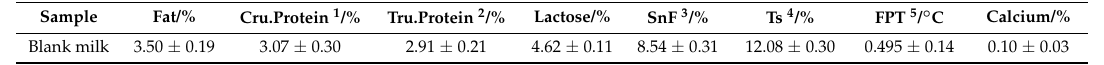
Table 1. The basic components of blank milk system. SnF, Ts, FPT